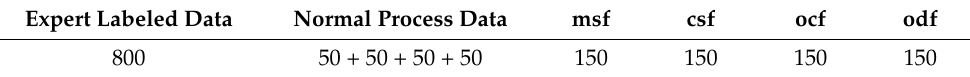
Table 1. The four types of fault process data are composed of 50 normal data and 150 fault data. Expert Labeled Data